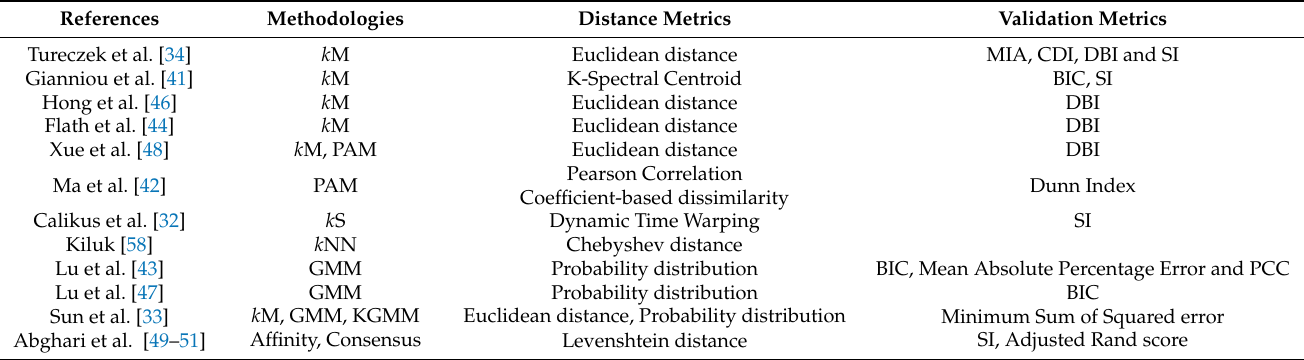
Table 3. Summary of applications of clustering